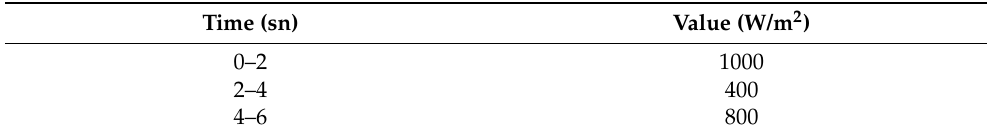
Table 7. Variable solar radiation values.